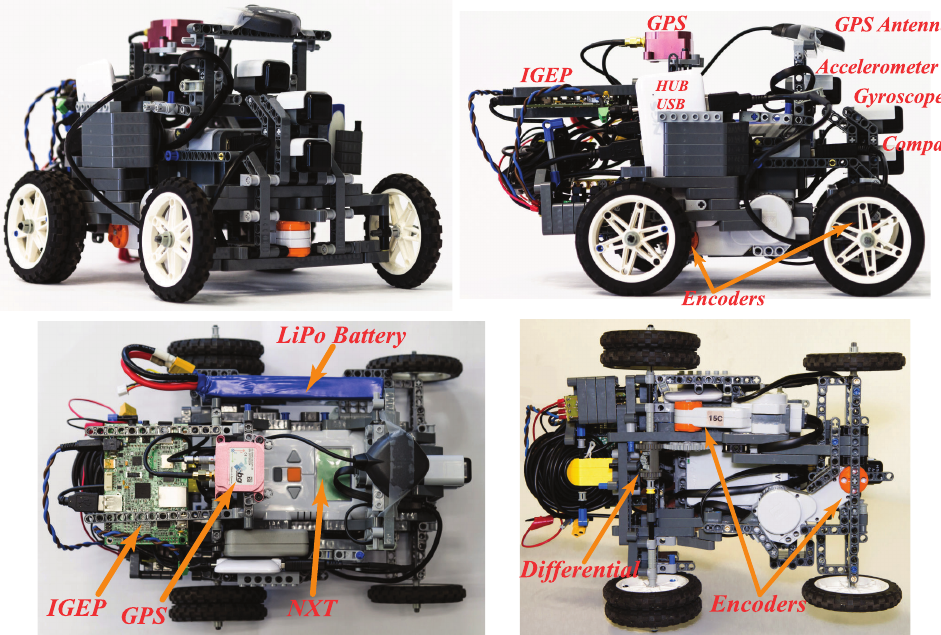
Figure 4. Ackermann LEGO NXT mobile robot with outdoor GPS